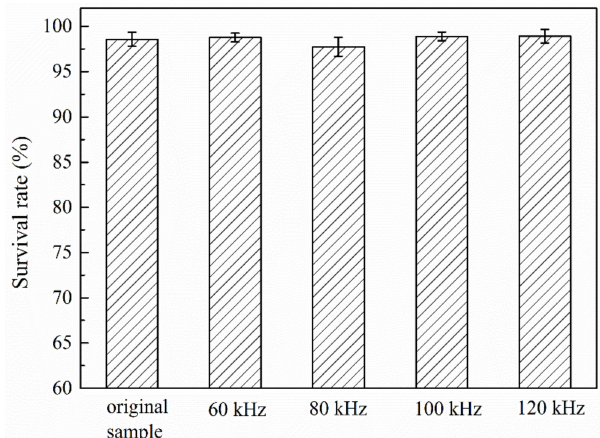
Figure 2. Influence on bacteria viability due to C 4 D detection by analyzing the ratio of live to dead cells. The recovered bacteria were labeled with Propidium Iodide (PI) and analyzed by flow cytometry (FCM). Error bars are standard deviations of four